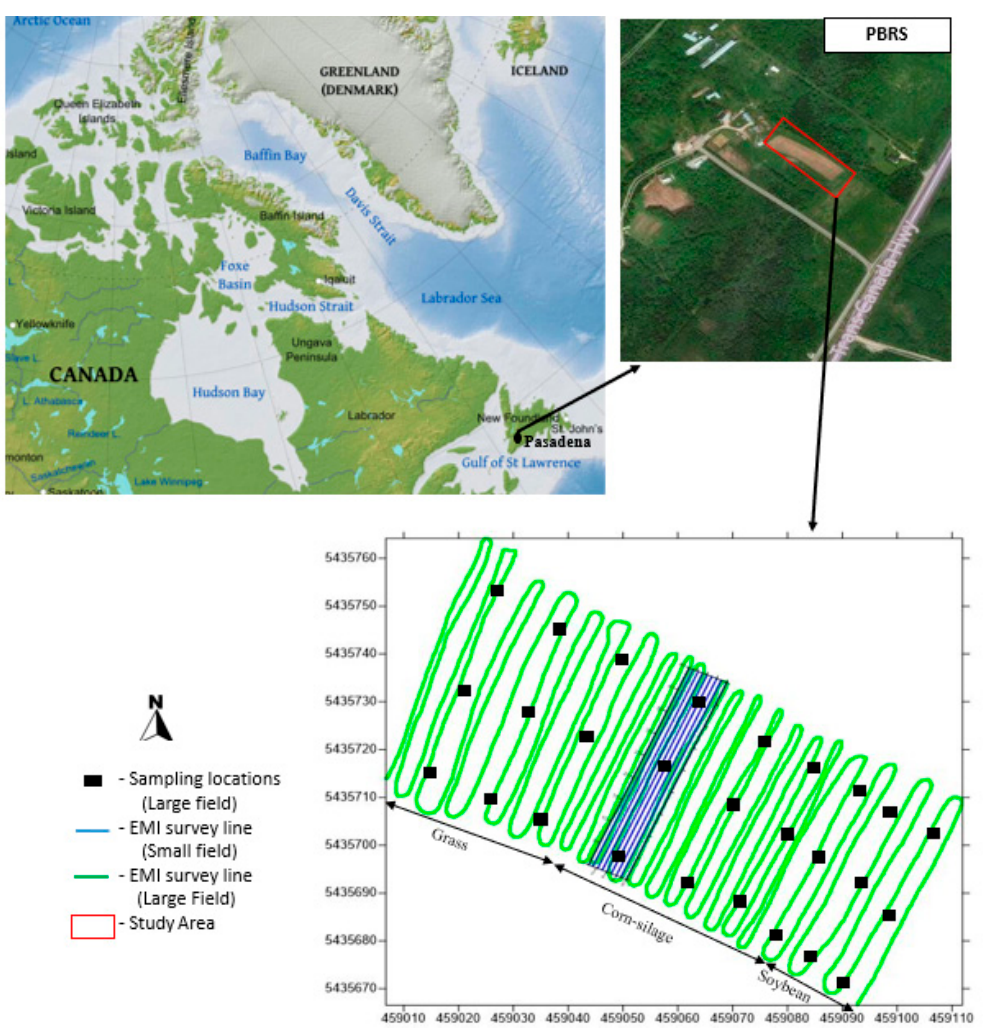
Figure 1. The location of Pynn’s Brook Research Station (PBRS), Pasadena (49°04’20” N, 57°33’35” W) in Newfoundland, Canada and the study site.